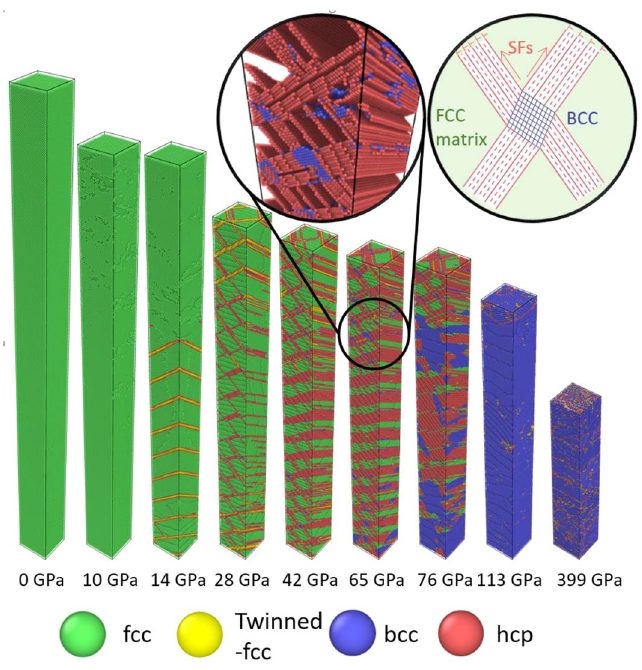
Figure 2. Atomistic snapshot of a representative slice from SC NEMD at different global stress states. The loading direction is from bottom to top. The magnification of the circled area shows the initial bcc nucleation, where fcc atoms are not displayed for